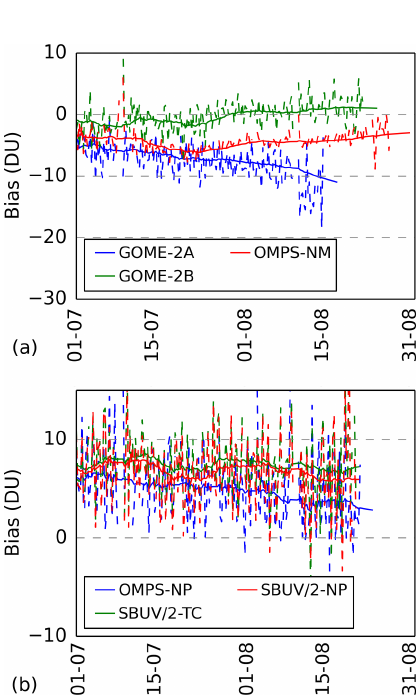
Figure 4. Time series of total column ozone bias corrections (DU) for July and August 2014 for GOME-2A/B, OMPS-NM/NP, and SBUV/2-TC/NP as derived from the colocation method described in Sect. 4.1. Dashed vertical lines show individual 6h mean differ- ences with OMI-TOMS, while the solid curves of the same colour show the 2-week moving average bias corrections. The particular (latitude, solar zenith angle) bins plotted are 5 ◦ wide bins centred on (52.5 ◦ N, 37.5 ◦ ) for GOME-2A/B and OMPS-NM and a 10 ◦ wide bin centred on (55 ◦ N, 35 ◦ ) for OMPS-NP and SBUV/2-TC/NP. Time coverage for individual bins does not necessarily cover com- plete